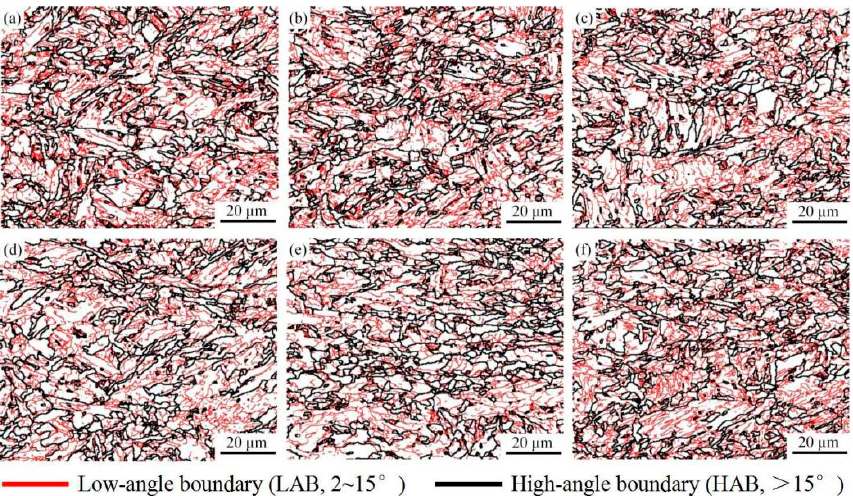
Figure 5. The EBSD images of grain boundary distribution map at different temperatures: ( a ) the as-rolled state; ( b ) holding at 300 °C for 15 min; ( c ) holding at 400 °C for 15 min; ( d ) holding at 500 °C for 15 min; ( e ) holding at 600 °C for 15 min; ( f ) holding at 700 °C for 15 min.